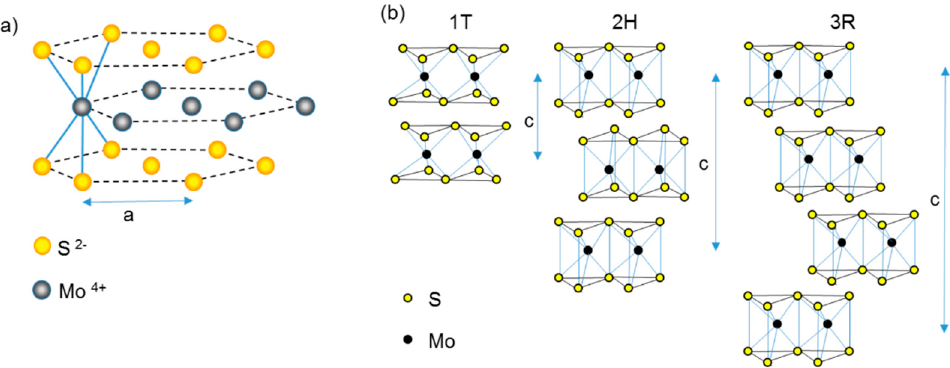
Figure 2. ( a ) Hexagonal structure of S and Mo layers; ( b ) side view schematic illustration of the 1T/2H/3R type structures of MoS 2 ; The number of layers in a repeat unit are shown by c . [17].